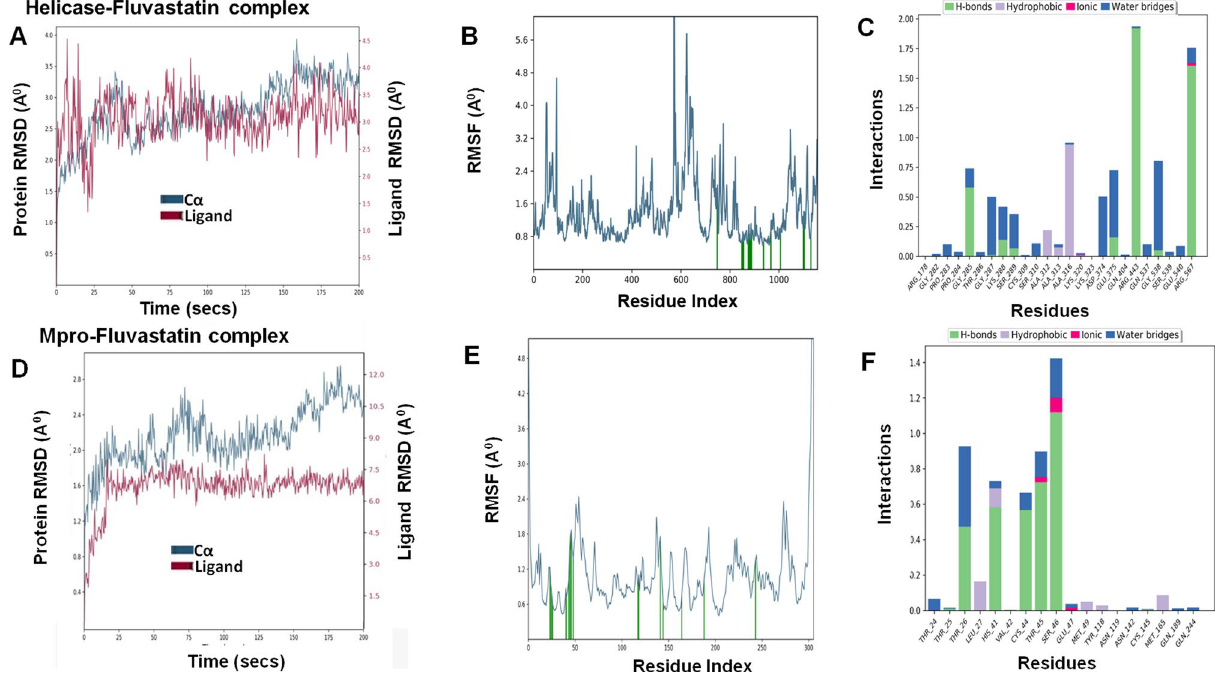
Figure 9. Molecular dynamic simulations of Helicase–fluvastatin complex (A–C) and Mpro–fluvastatin complex (D–F) , respectively. (A–C) RMSD, RMSF, and protein–ligand interactions of helicase–fluvastatin complex, respectively. (D–F) RMSD, RMSF, and protein–ligand interactions of Mpro–fluvastatin complex, respectively.